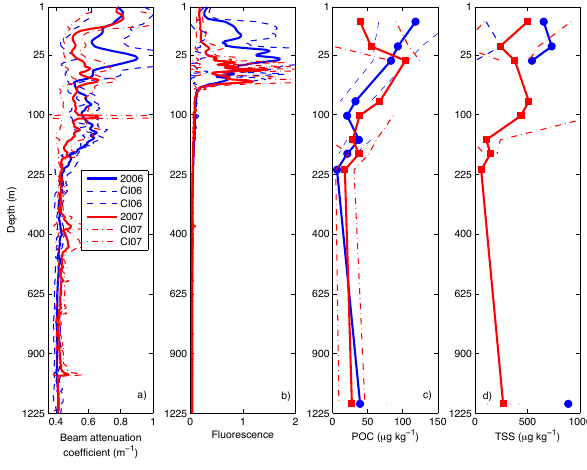
Fig. 3. As in Fig. 2 but for the western Beaufort shelf region. The upper 1600m are shown to include all attenuation features and bot- tle